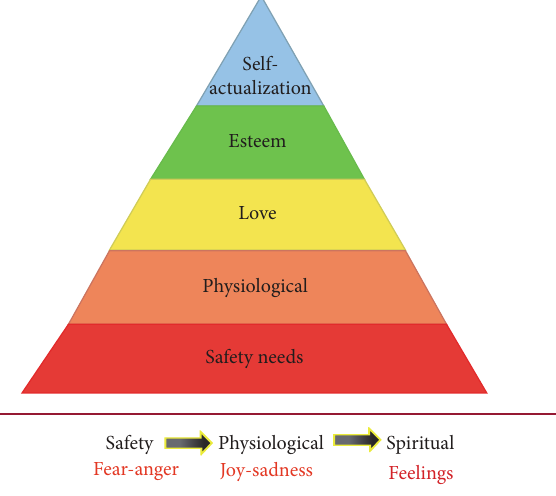
Figure 1: New version for Hierarchy of Needs : “ safety-hedonic- esteem-love-self-actualization ”. All emotions and feelings depend on whether the stimulus can satisfy the needs of individuals, and the satisfaction of different needs can induce different emotions: safety can induce fear and anger, hedonic needs can induce joy and sadness, and spiritual needs can induce feelings such as love.